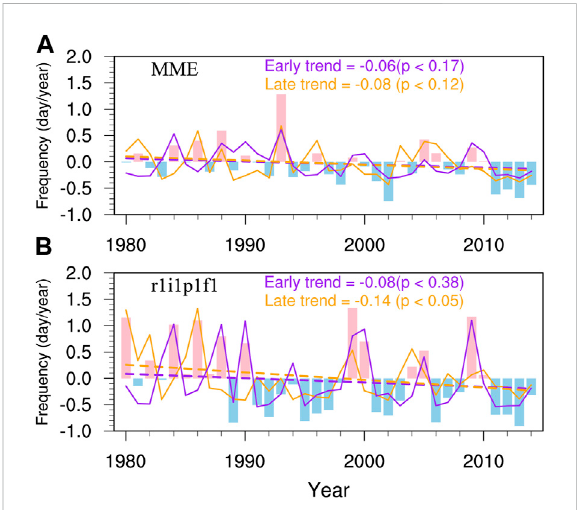
FIGURE 11 TimeseriesofthenumberofdayswithECEs(units:days/year) over eastern China in winter from 1980 to 2014 based on the FGOALS-F3-L data. (A) The ensemble mean of the three amip-hist simulations (MME), (B) the r1i1p1f1 ensemble member. The purple solid line represents early winter, the orange solid line represents late winter, the histogram shows the whole winter period, and the purple and orange dashed lines are the linear trends of early and late winters,